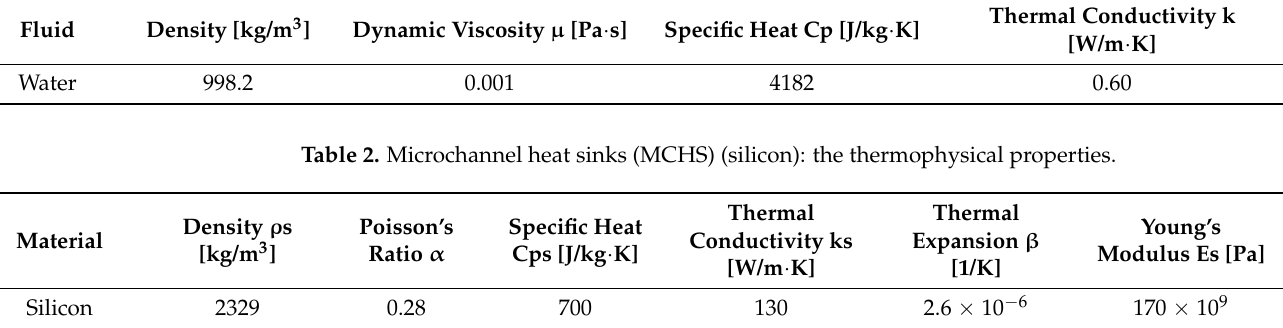
Table 1. Heat transfer fluid (water): the thermophysical properties. Fluid Density [kg/m 3 ]